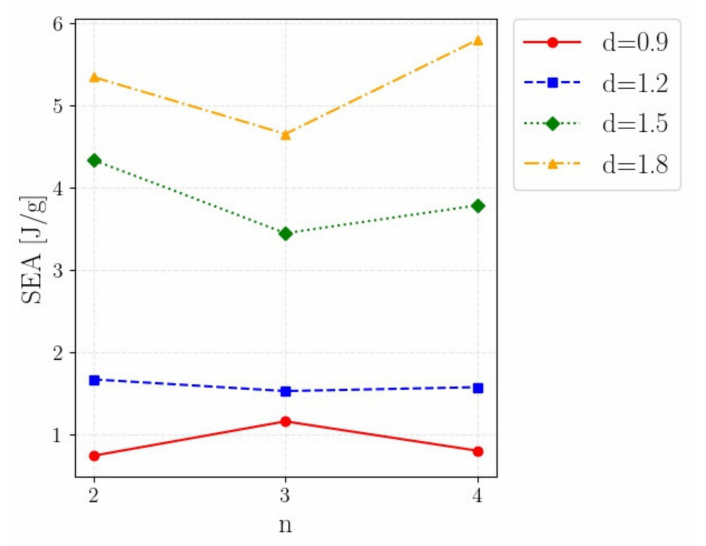
Figure 8. Interaction plot showing the average SEA with respect to the parameter n for the investi- gated d